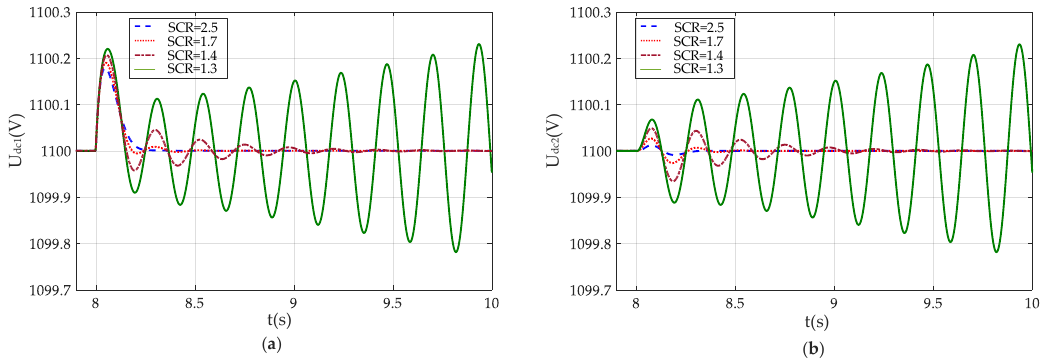
Figure 12. DC-link voltage responses under different grid strengths in ( a ) VSC1, ( b ) VSC2.